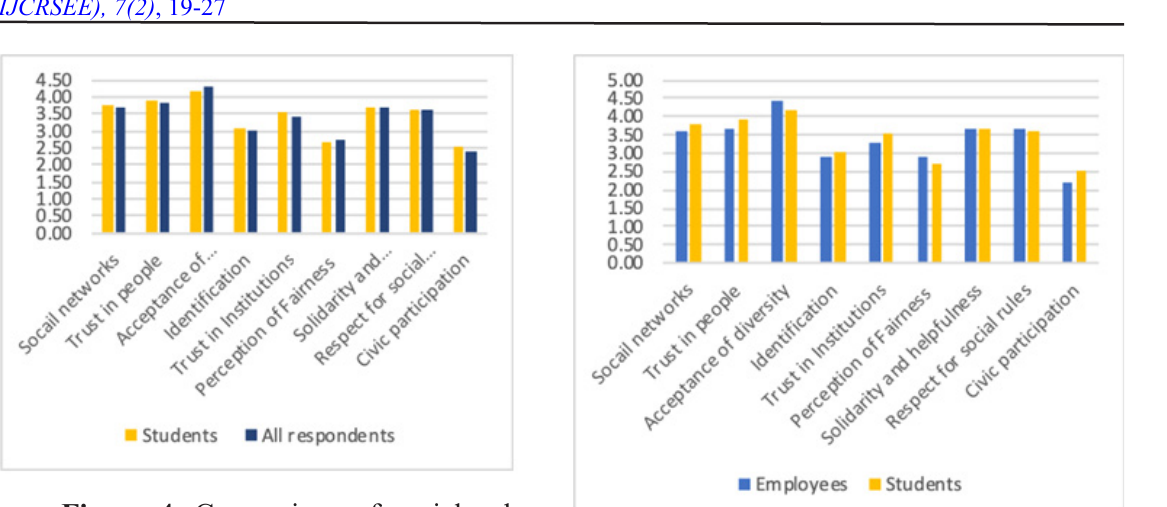
Figure 4. Comparison of social cohe- sion between all respondents and students by dimensions